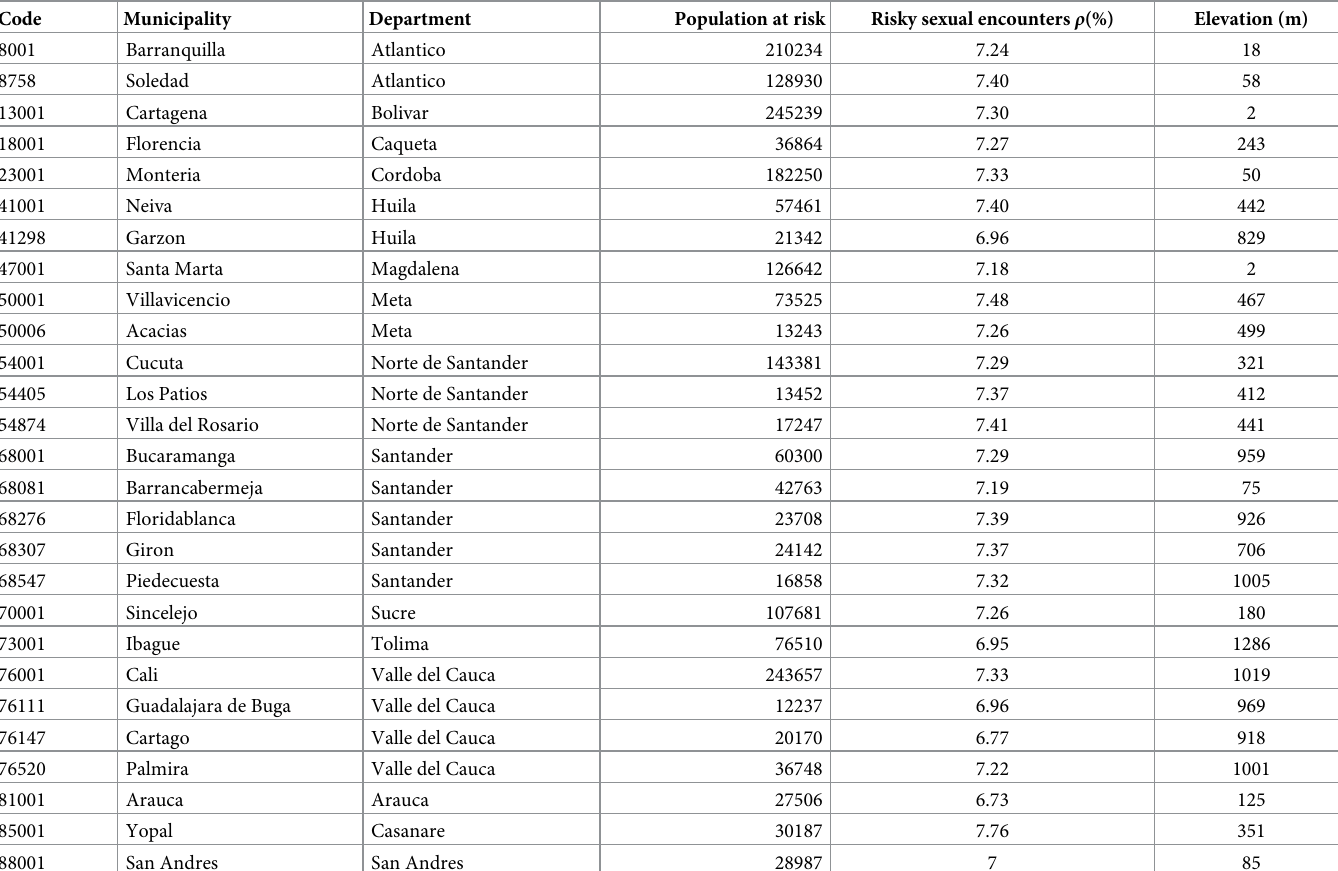
Table 2. Estimated at risk population by